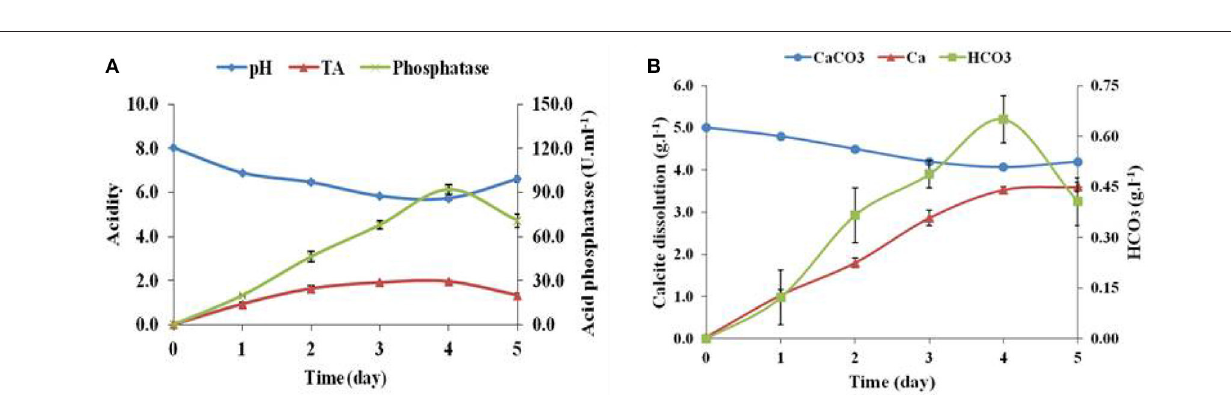
FIGURE 5 | Calcite dissolution of Brevibacterium sp. SOTI06. Acidity in terms of pH and TA (g.l − 1 ) indicated their inverse proportion and increase in acid phosphatase activity (U.ml − 1 ) (A) ; Calcite dissolution (CaCO 3 content and Ca 2 + release) and HCO 3 (B) of Brevibacterium sp. SOTI06 over the period of 5 days. The pH was decreased from day 0 to 4. Whereas, the Ca 2 + and HCO 3 content increased over a period and a decrease in CaCO 3 content indicated that dissolution occurred by the bacterium. Means of three replicate values plotted and error bars indicate the standard